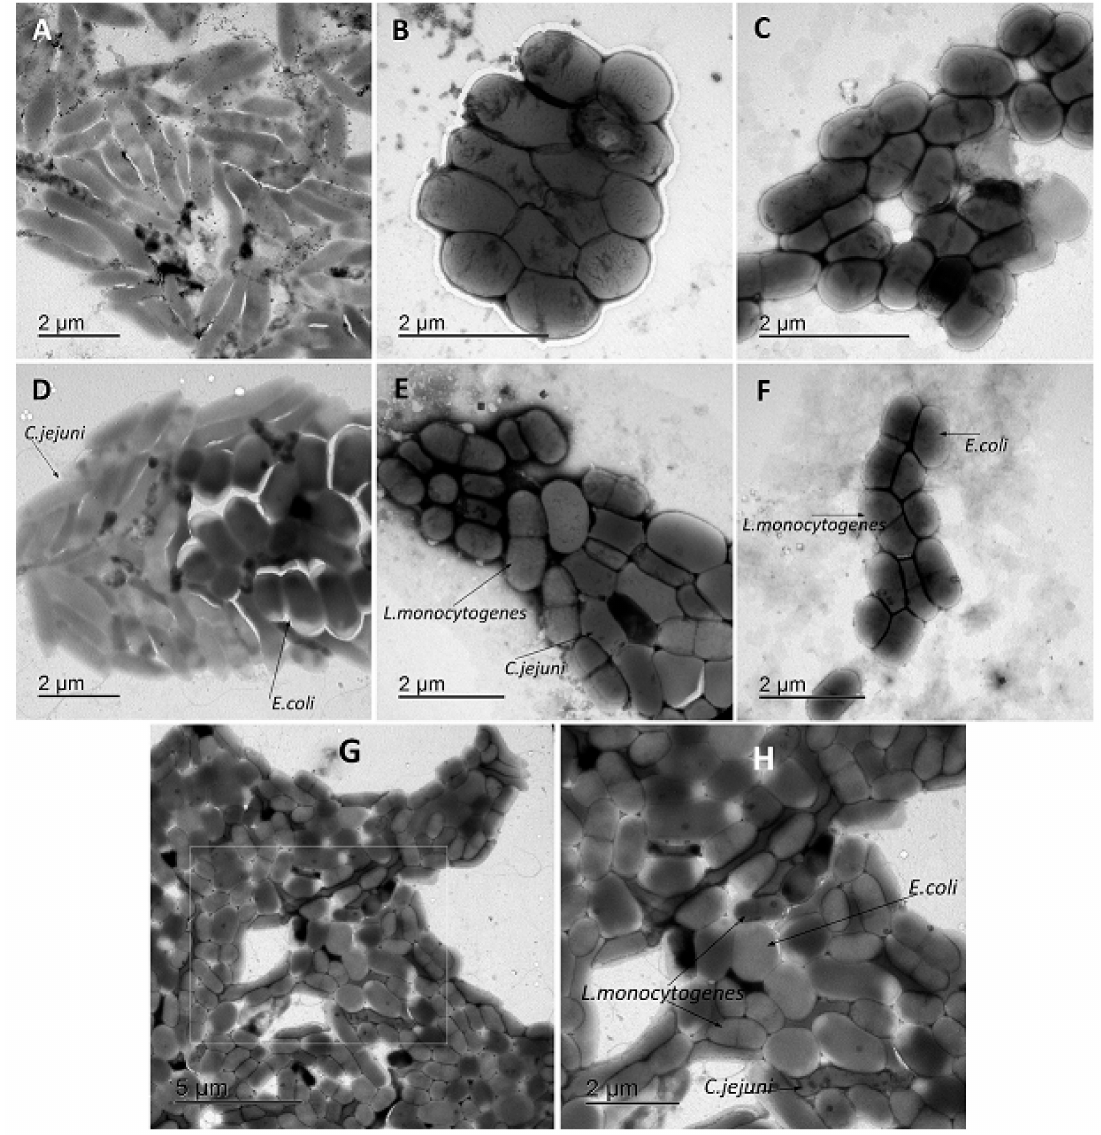
Figure5. Representativetransmissionelectronmicrographsofthebacterialaggregationandco-aggregation. ( A ) C. jejuni . ( B ) E. coli . ( C ) L. monocytogenes . ( D ) Mixed culture of C. jejuni and E. coli . ( E ) Mixed culture of C. jejuni and L. monocytogenes . ( F ) Mixed culture of E. coli and L. monocytogenes . ( G ) Mixed culture